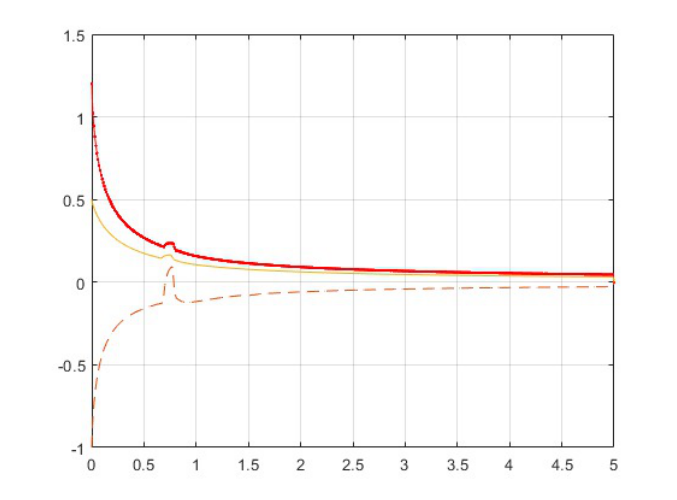
Figure 7. Graph represents error state ω j ( τ ) of a multi-agent system following leader.